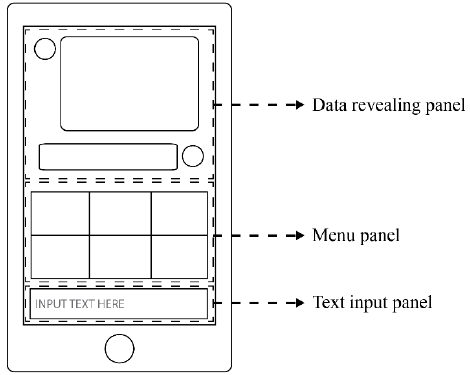
Figure 3. The designed user interface of Ask Diana.